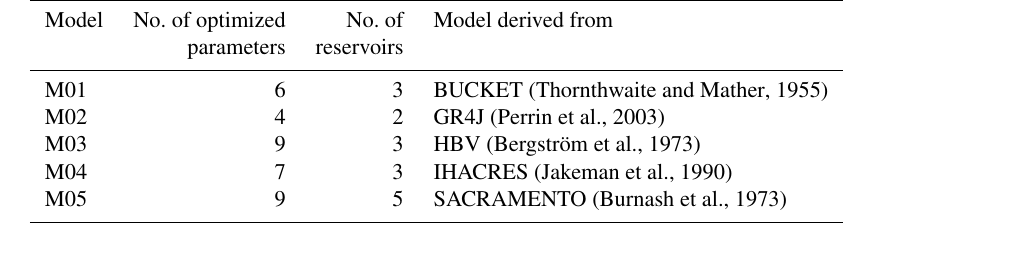
Table 2. Main characteristics of the hydrologic models (Seiller et al., 2012). Model No. of optimized No. of Model derived from parameters reservoirs M01 6 3 BUCKET (Thornthwaite and Mather, 1955)